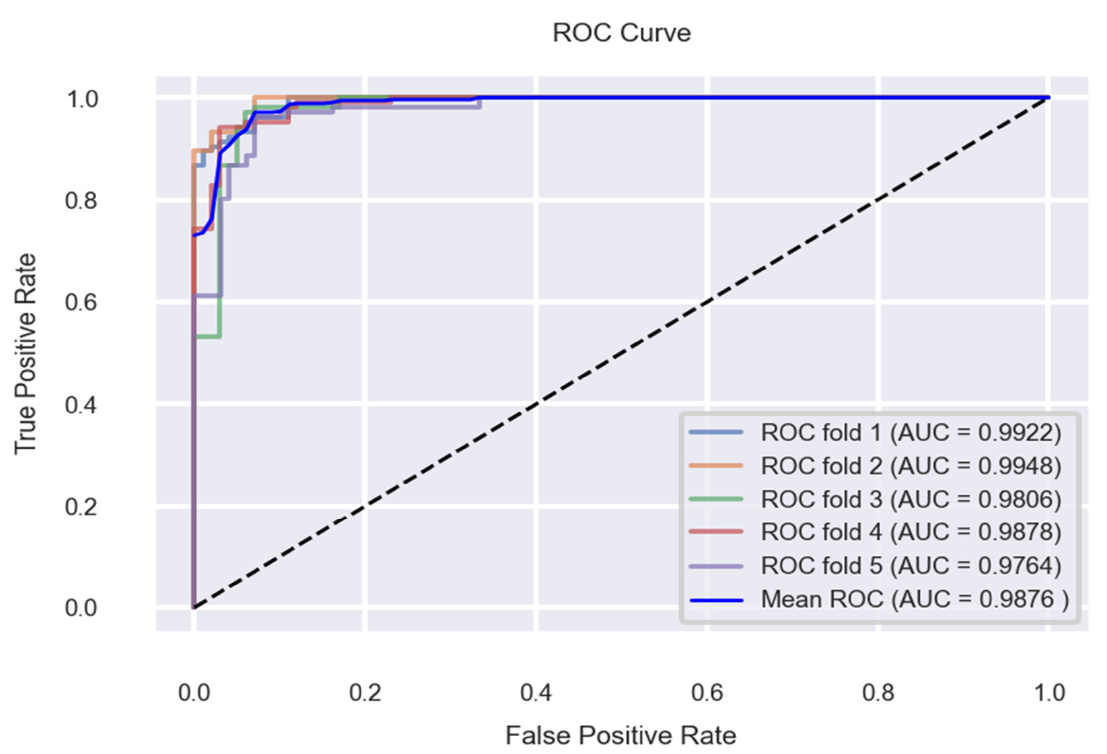
Figure 27. Stratified (K = 5)-Fold Cross-validation Results for Linear Discriminant Analysis (ROC- AUC).